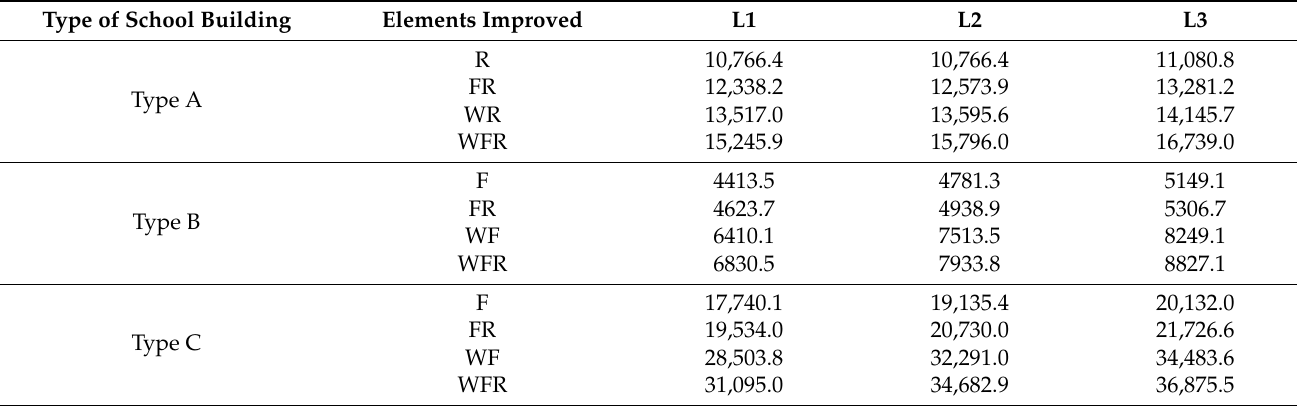
Table 6. Emission reduction compared to the initial state per year, according to type of school building and sets of measures. Expressed in KgCO 2 per year and according to building.